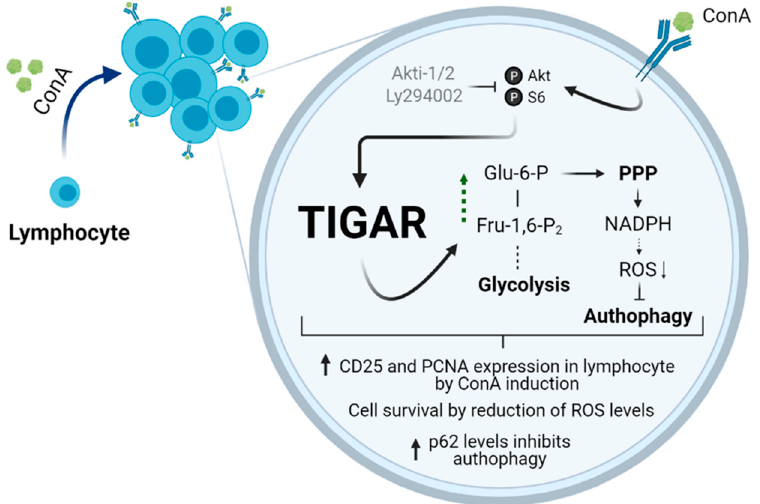
Figure 7. Graphical abstract of the main findings of this work. Mitotic agents such as ConA induce TIGAR in a PI3K/Akt-dependent manner. The activation of this pathway promotes cell survival, reduction of ROS by increasing PPP, and cell proliferation. Abbreviations: ConA, Concanavalin A; TIGAR, TP53 induced glycolysis and apoptosis regulator; Glu-6-P, glucose-6-phosphate; PPP, pentose phosphate pathway; Fru-1,6-P2, fructose-1,6-bisphosphate; ROS, reactive oxygen species. Created in BioRender.com (accessed on 21 May 2021).